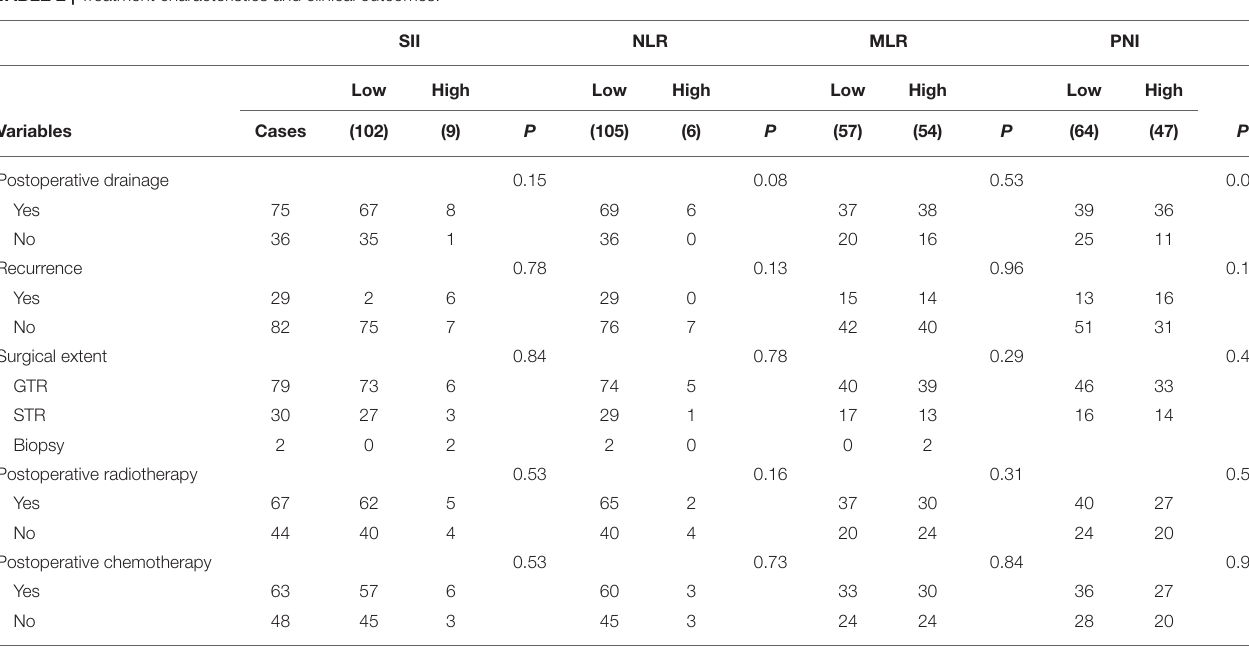
TABLE 2 | Treatment characteristics and clinical